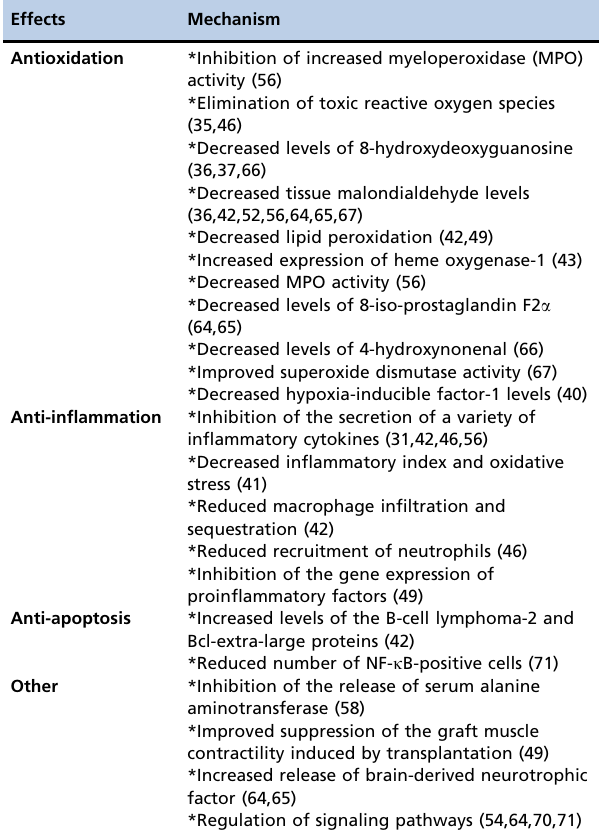
Table 1 - Mechanisms of the therapeutic effects of hydrogen on ischemia-reperfusion injury and graft- versus -host